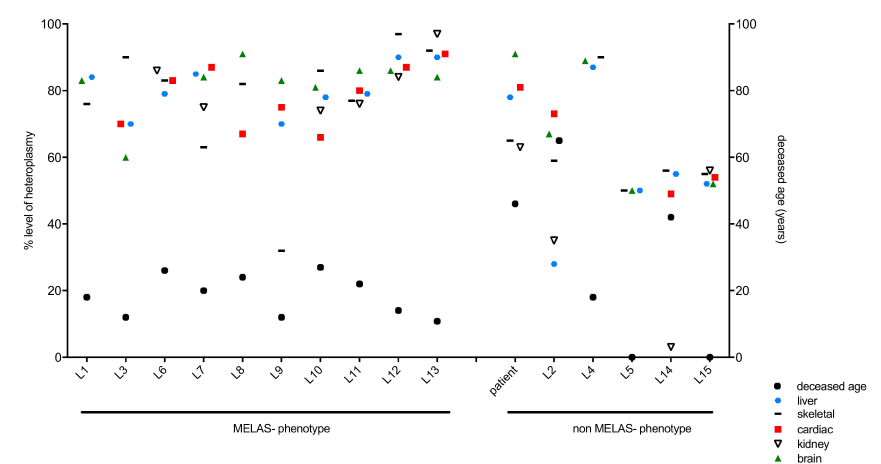
Figure 2. m.3243A > G heteroplasmy levels across literature cases with regard to tissues and clinical phenotype MELAS (mitochondrial encephalopathy, lactate acidosis and stroke-like episodes) versus non-MELAS. Table 2. Post-mortem (PM) mtDNA heteroplasmy (%) levels and mtDNA copy number of the patient presented in this study in tissue from the central nervous system ( n = 14) and peripheral organs ( n = 16). Heteroplasmy Levels (%) mtDNA Copy Number Tissue Type (Origin) by RFLP MT-ND1 /